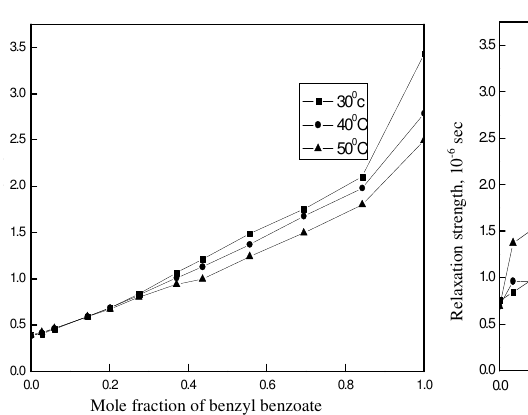
Figure 2(h). Variation of relaxation time with mole fraction of benzyl benzoate in the mixture of benzyl benzoate + benzonitrile